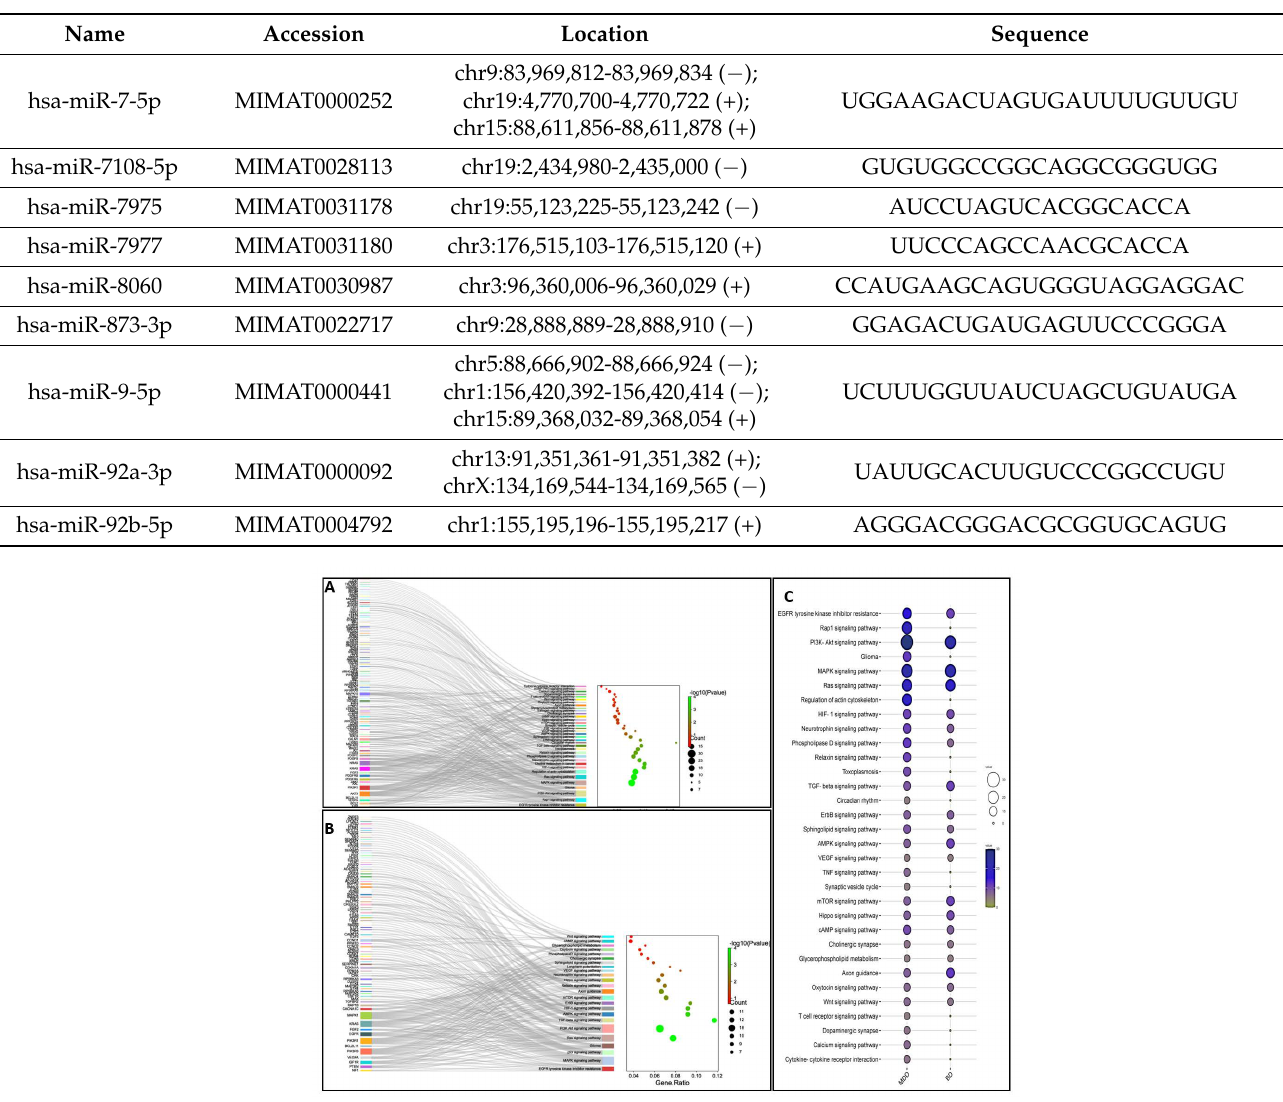
Figure 2. ( A ) Sankey plot showing biological pathways connected with the genes targeted by 129 MDD-associated miRNAs; ( B ) Sankey plot showing biological pathways connected with the genes targeted by 91 BD-associated miRNAs; ( C ) Comparative similarities and differences in biological pathways targeted by miRNAs selectively associated with MDD and BD.